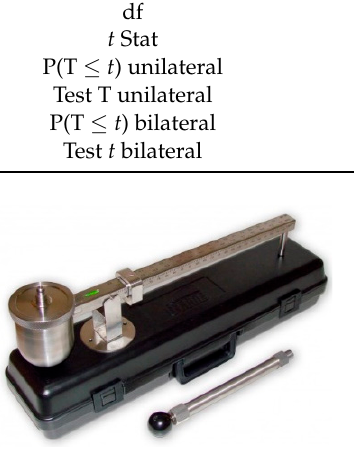
Figure 1. Baroid weight.